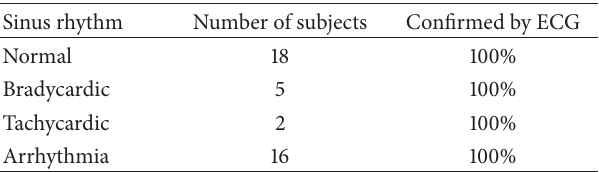
Figure 9: Statistical box-plot. 𝑥 -axis: results of the PSS question- naire; 𝑦 -axis: participants divided by the algorithm into “stressed” and “nonstressed.” Table 4: Results of the sinus rhythm classification and the sinus arrhythmia detection